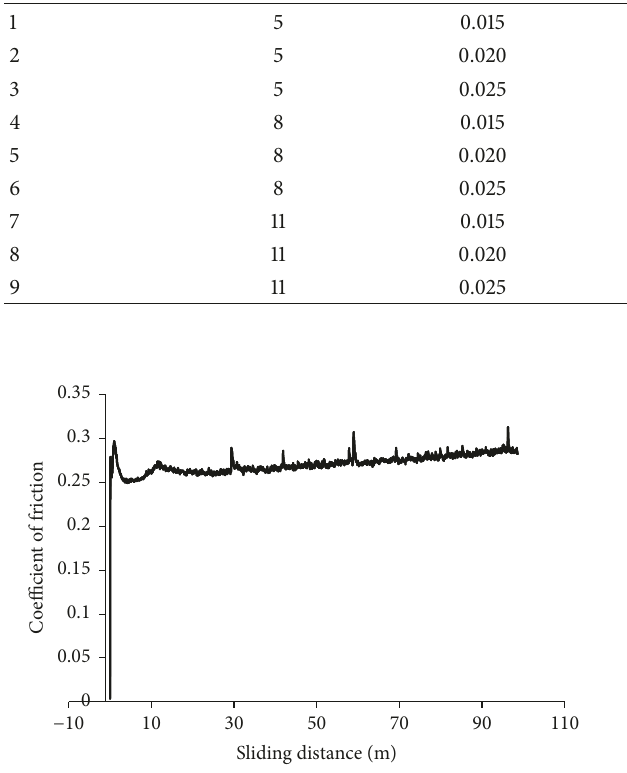
Figure 1: Typical variation of COF with time at 616 MPa contact pressure and 0.015 m/s sliding speed.